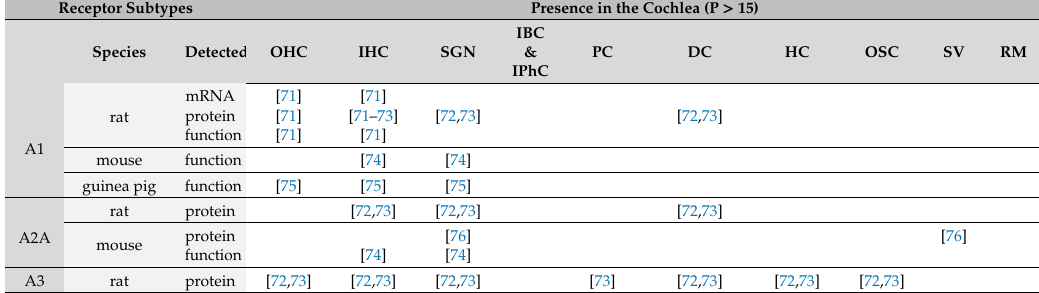
Table 3. Expression of ectonucleotidases in the cochlea before and after hearing onset (P15) in rodents. It includes only subtype and cell specific results. mRNA detection means PCR analysis and in situ hybridization, protein detection means Western-blot analysis and immunohistochemistry, while functional detection indicates pharmacological analysis in electrophysiological or Ca 2 + imaging experiments. NTPDases: Ectonucleoside triphosphate diphosphohydrolase isoenzymes; IHC: